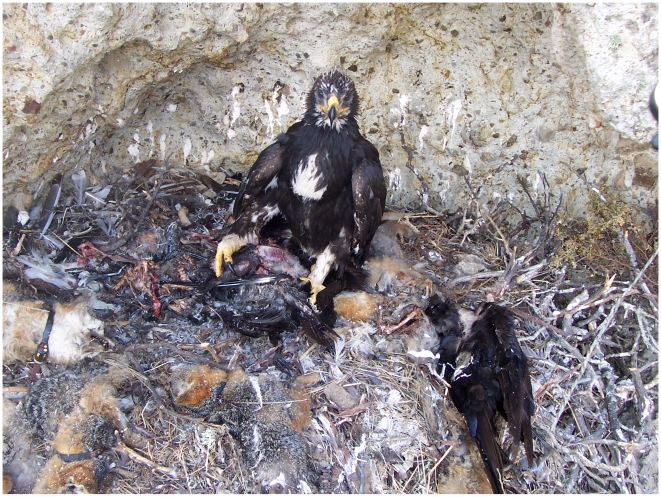
The nestling golden eagle of the Laguna Pair and her food.In June 2006, the nest of the Laguna Pair contained remains of 13 island foxes (note radio-telemetry collars), 11 common ravens and 12 seabirds (Photo credit: P. Sharpe).